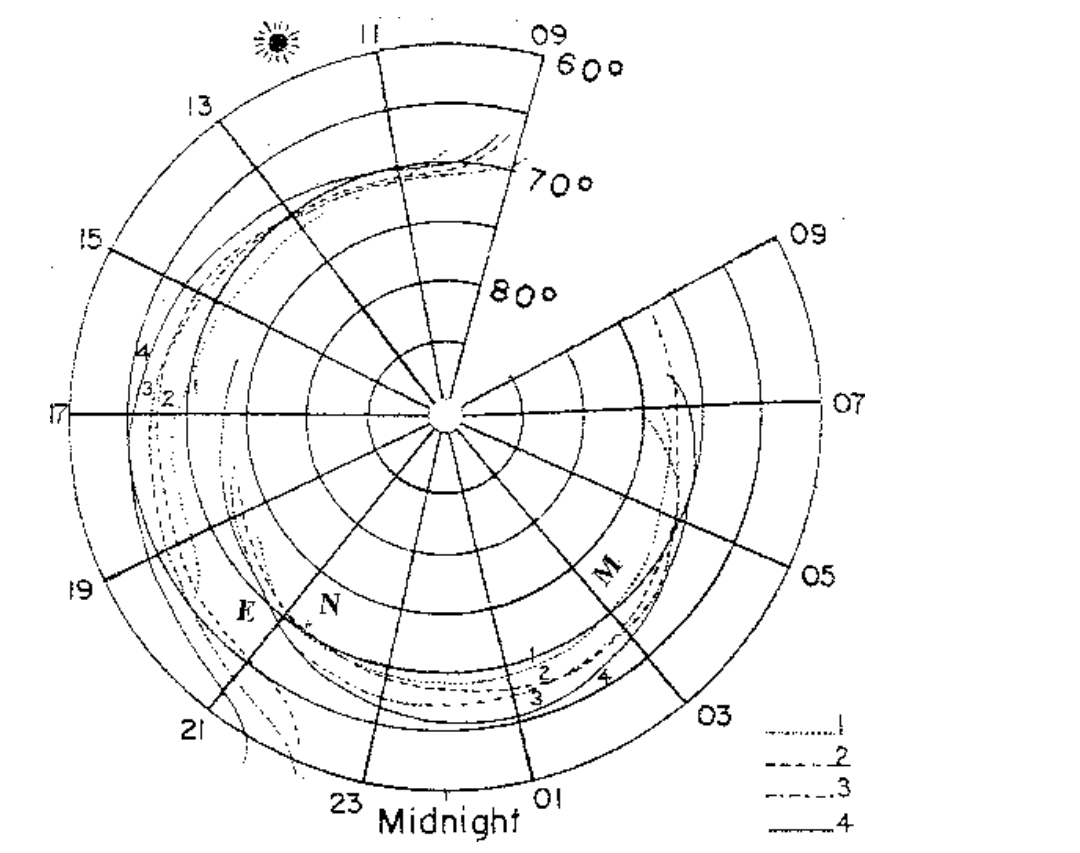
Figure 2. Loci of maximum intensity of auroral-zone electric currents (electrojets), as observed on geomagnetic meridian 120 ◦ , for di ff erent ranges of storminess (1,2,3,4). Mean picture for ∆ H and ∆ Z fields, letters M, N, and E correspond to morning, nighttime, and evening spirals (Harang,